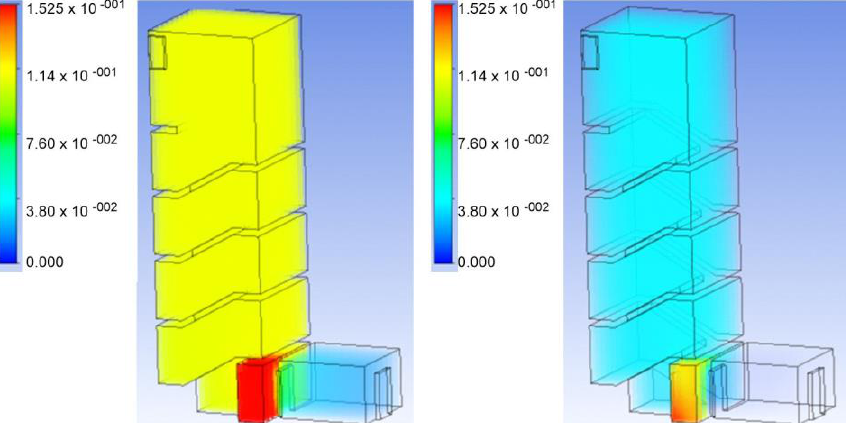
Figure 11. Carbon dioxide distribution in the staircase before ( left ) and after ( right ) axial fan application. Carbon dioxide was measured as a mass fraction.